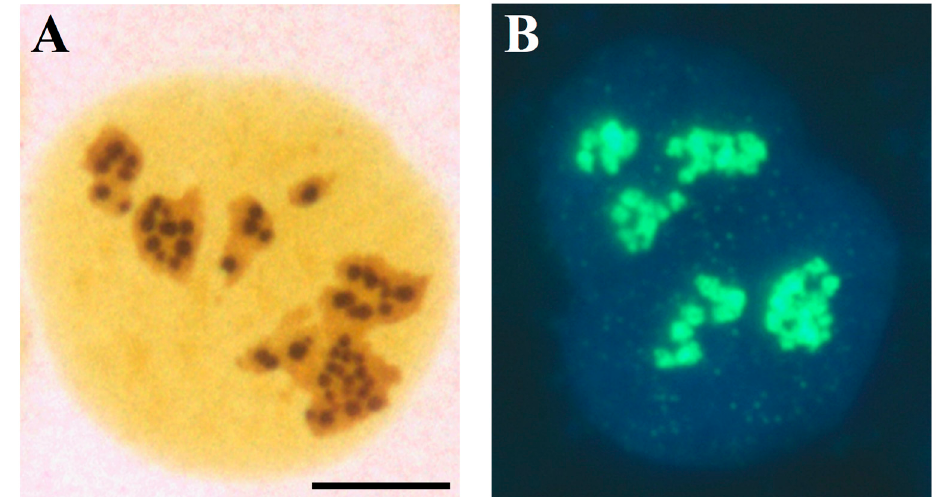
Figure 2. The AgNORs are the sites where rRNA synthesis takes place in the nucleolus; ( A ) light microscopy visualization of a U2OS cell (established cell line from a human osteosarcoma) after specific silver staining for NOR proteins. The silver-stained structures appear as well-defined, darkly stained dots clustered in the three nucleoli. ( B ) Visualization of rRNA synthesis in a U2OS cell, labelled with 5-fluorouridine (FUrd) for 15 min. FUrd was revealed by specific FITCH-conjugated monoclonal antibodies. DAPI counter-staining. Note the spot-like distribution of the sites of the nucleolar rRNA transcription, which overlaps that of the silver-stained dots in Figure 4. Bar = 10 µm.